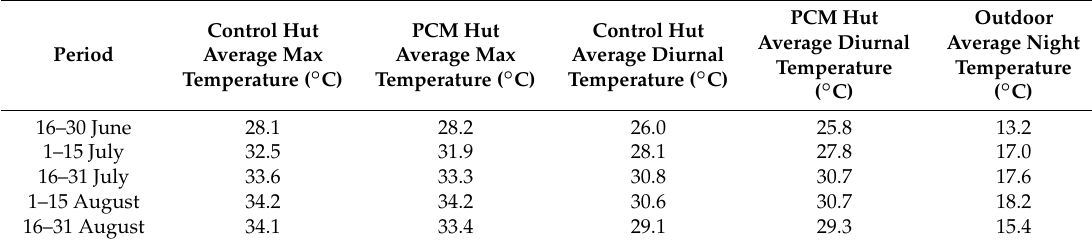
Table 7. Average temperatures of the huts during heating